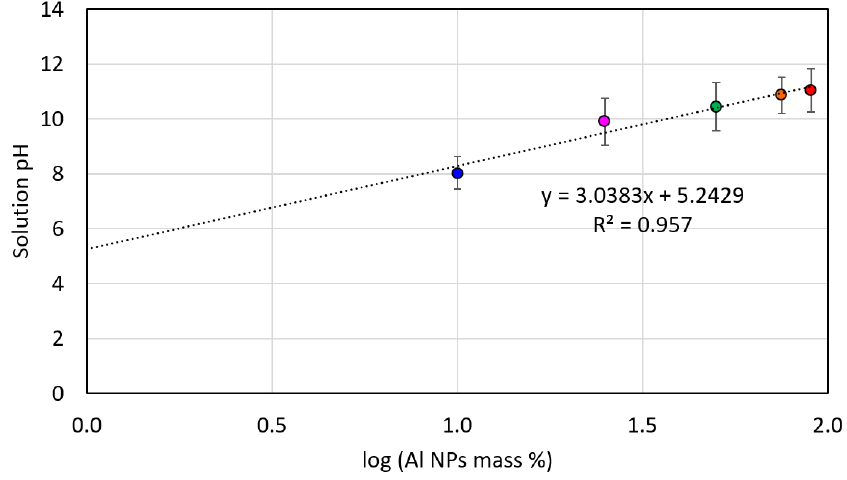
Figure 6. Dependence of reaction solution pH on Al NP mass %.